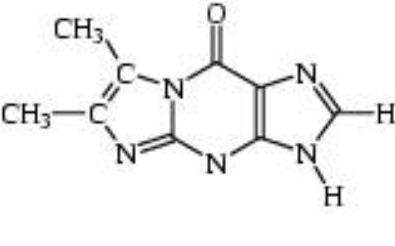
Figure 2. The wybutine model used in the present